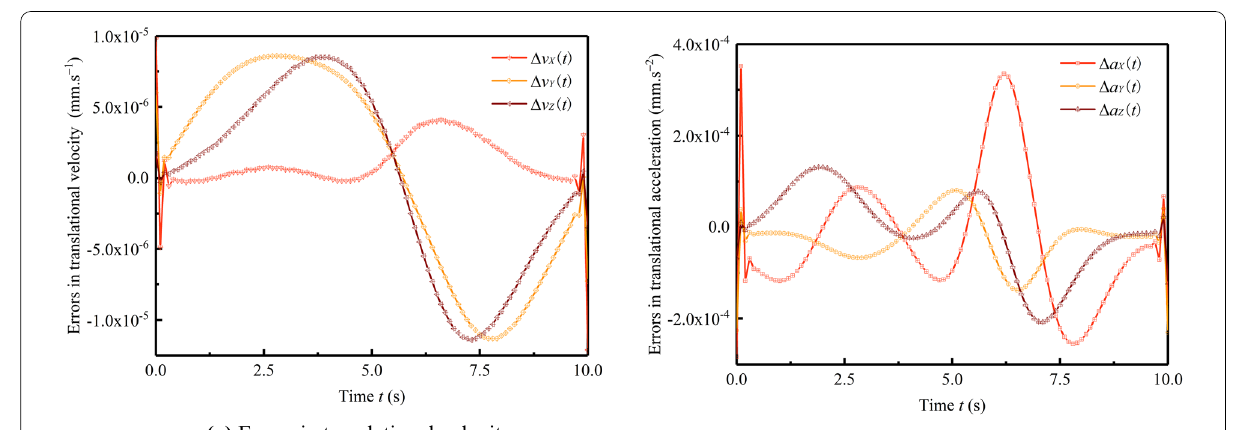
Figure 17 Translational motion error between the proposed method and